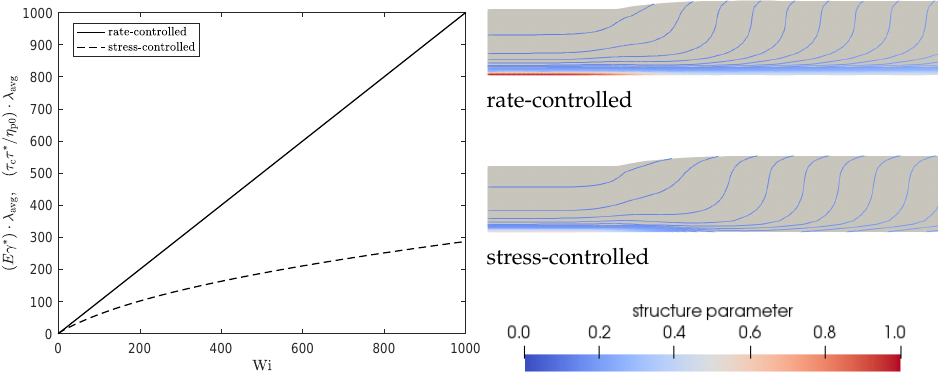
Figure 13. Damage terms of the rate and stress-controlled approaches as a function of Weissenberg number in steady shear ( left ). Contour plots of the structure parameter ξ for λ θ = 10 λ avg an γ ∗ = 1 for the rate-controlled approach and the corresponding values for the stress controlled approach ( right ). Unless indicated otherwise, all contour plots presented in this paper are made with equidistant contour lines with an interval of